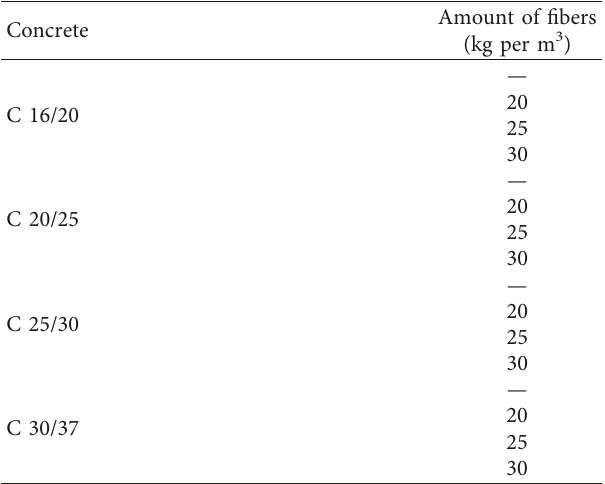
Table 1: Design of construction concrete with individual amounts of steel fibers [7].